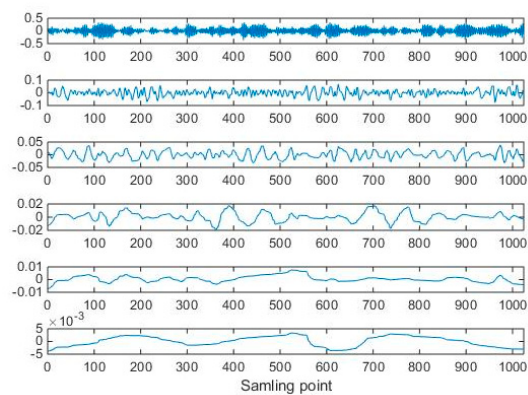
Figure 8. The intrinsic time-scale decomposition (ITD) results of the vibration signal with the ball elements of the rolling bearing under the fault diameter of 7 mils with the load 0 hp.